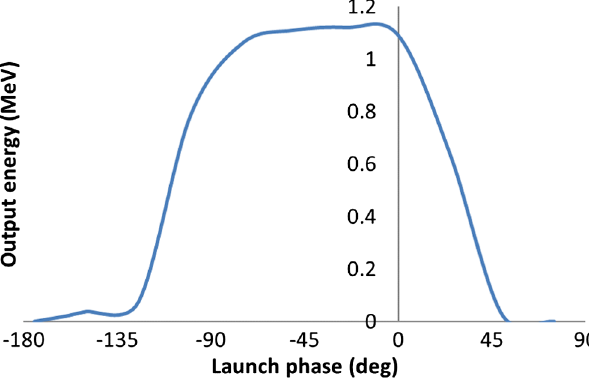
FIG. 8. Plot of the electron beam energy as a function of the launch phase.